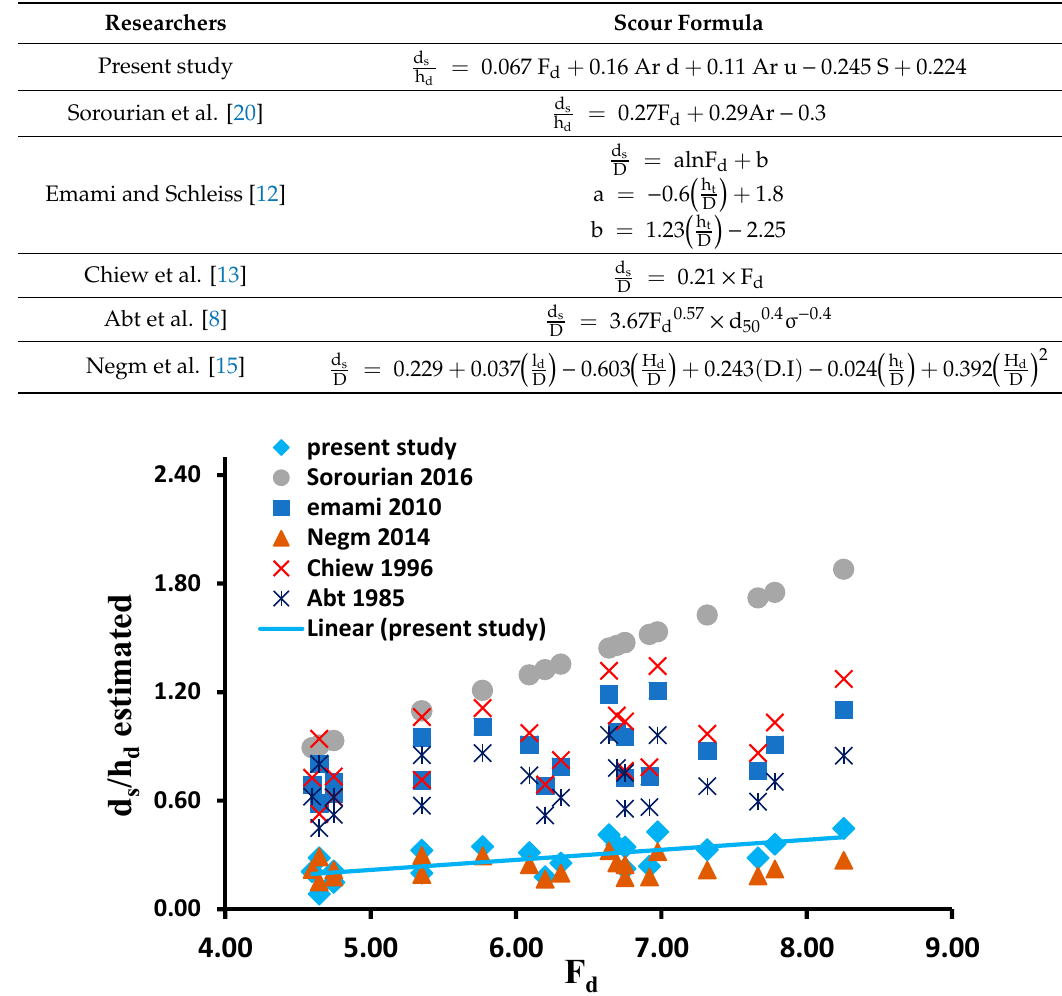
Figure 16. Comparison of relative maximum scour depths estimated using the formula proposedin the present study, and using other scour formulas with the same F d range.